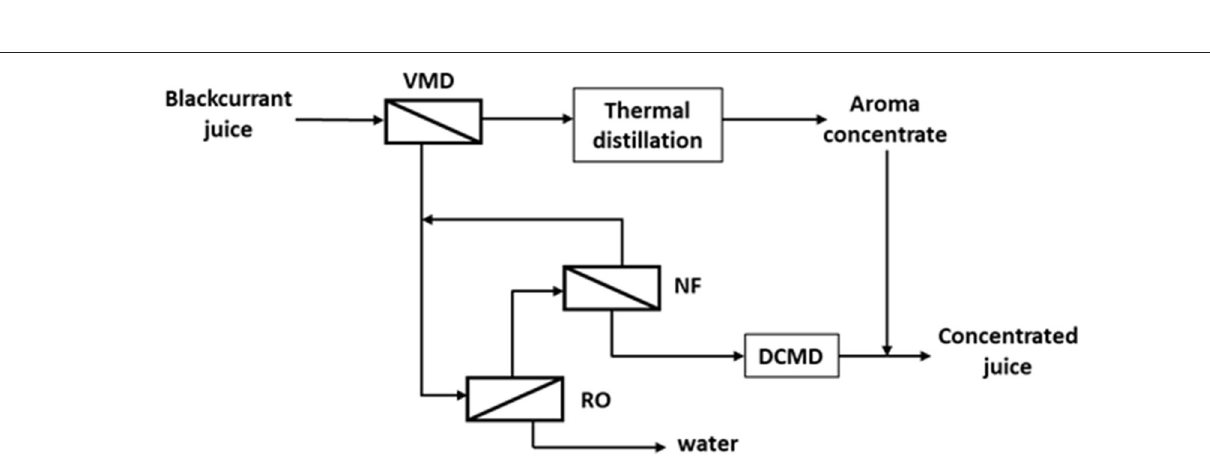
FIGURE 6 | Schematic process layout for concentration of blackcurrant juice based on membrane processes (VMD, vacuum membrane distillation; RO, reverse osmosis; NF, nanofiltration; DCMD, direct contact membrane distillation) adapted from Sotoft et al. (55,